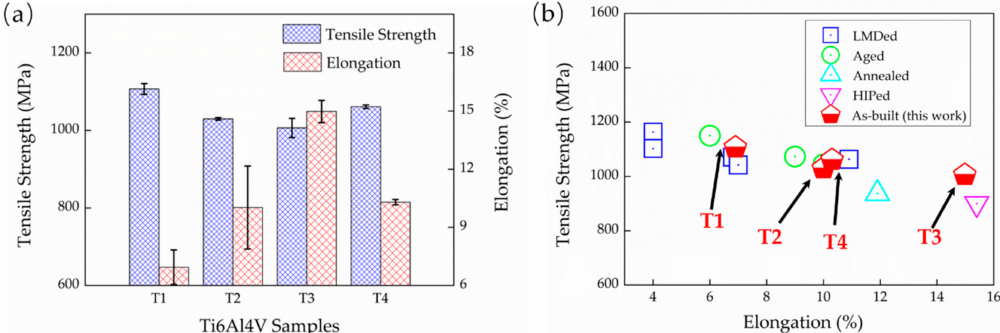
Figure 15. ( a ) Histogram of ultimate tensile strengths ( σ U ) and elongation (e f ) in the present work, and ( b ) tensile properties comparation between the LMD Ti6Al4V reported by Liu et al [4] and present